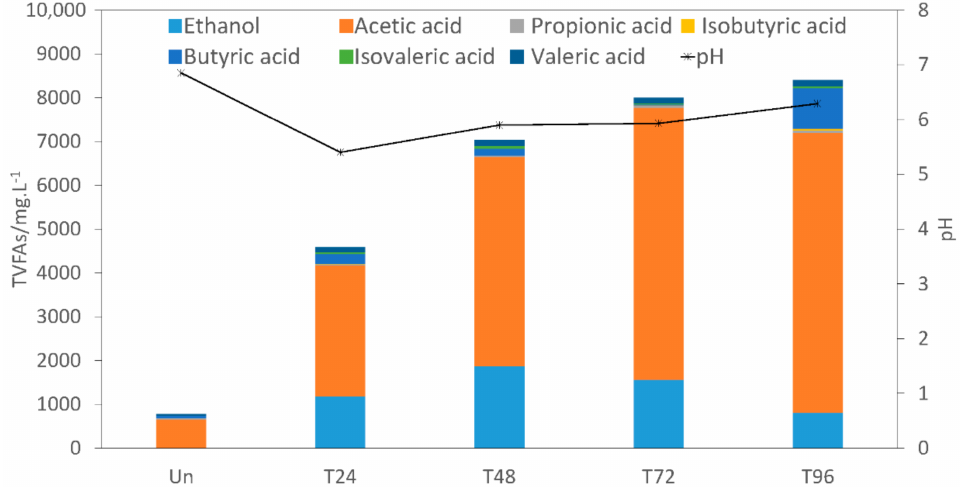
Figure 4. The changes of TVFAs, pH, and ethanol before and after